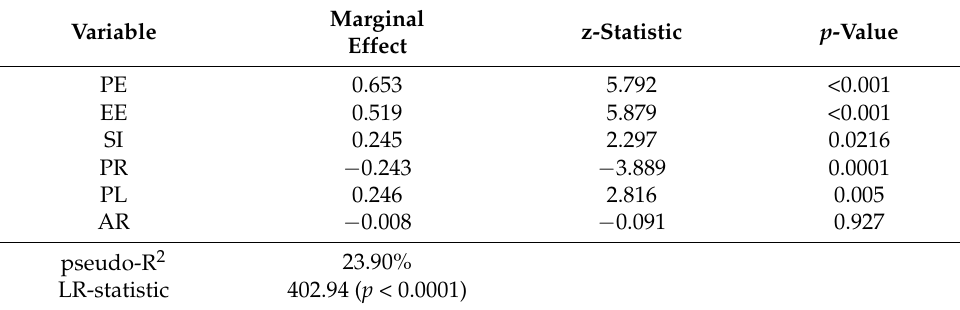
Table 3. Results of the ordered logistic regression on